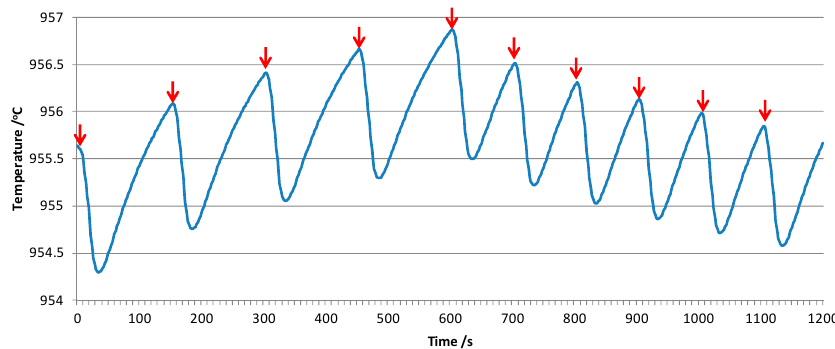
Figure 2. Temperature fluctuation curve of one cycle in case 1 (arrow refers to feeding moment of number 6 feeder).